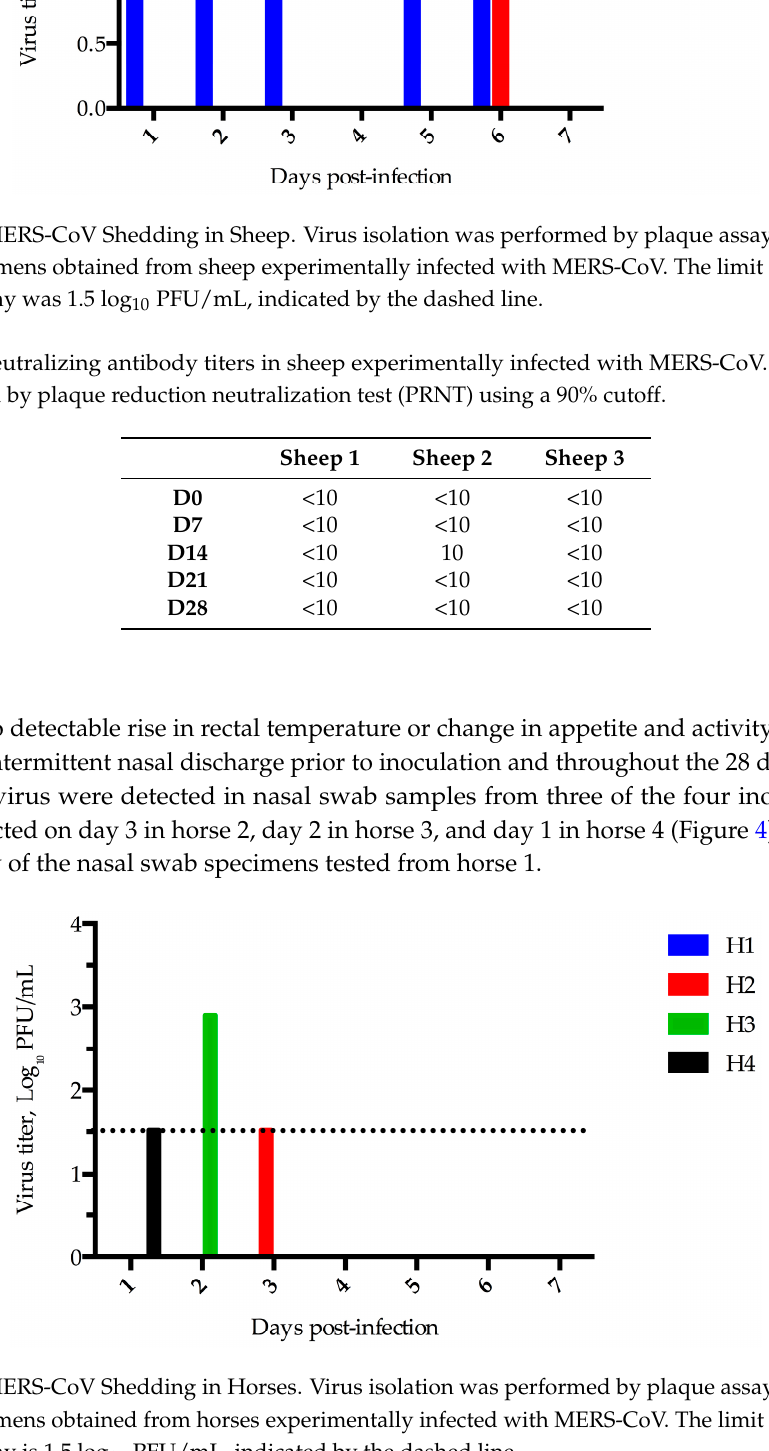
Table 3. Neutralizing antibody titers in horses experimentally infected with MERS ‐ CoV. Titers were determined by PRNT using a 90% cutoff. Horse 1